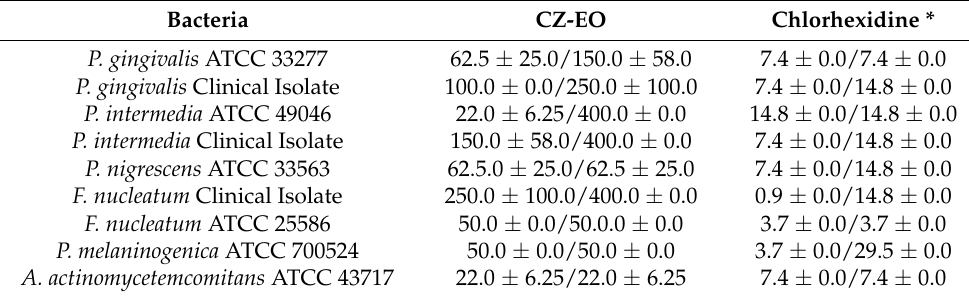
Table 2. Minimum Inhibitory Concentration (MIC) and Minimum Bactericidal Concentration (MBC) values ( µ g/mL) of CZ-EO and the positive control (Chlorhexidine) against periodontopathogenic bacteria.